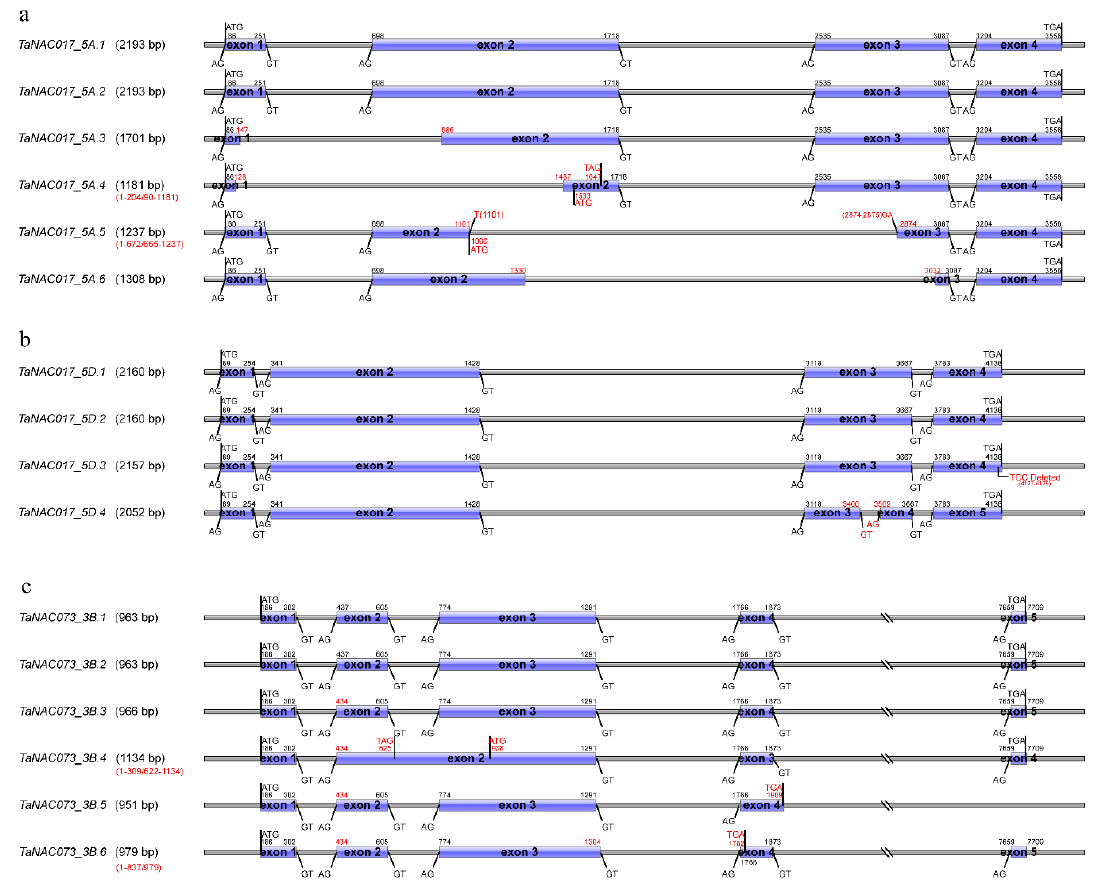
Figure 3. Structural patterns of 16 different transcripts from three TaNAC genes selected for description. (a) TaNAC017_5A corresponded to TraesCS5A02G271500, which was located